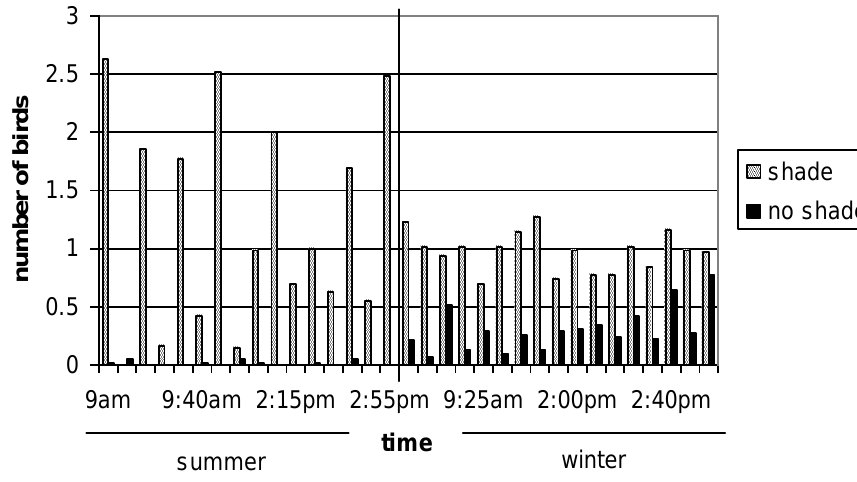
Figure 2. Average number birds in shade and non shade areas over a summer and winter